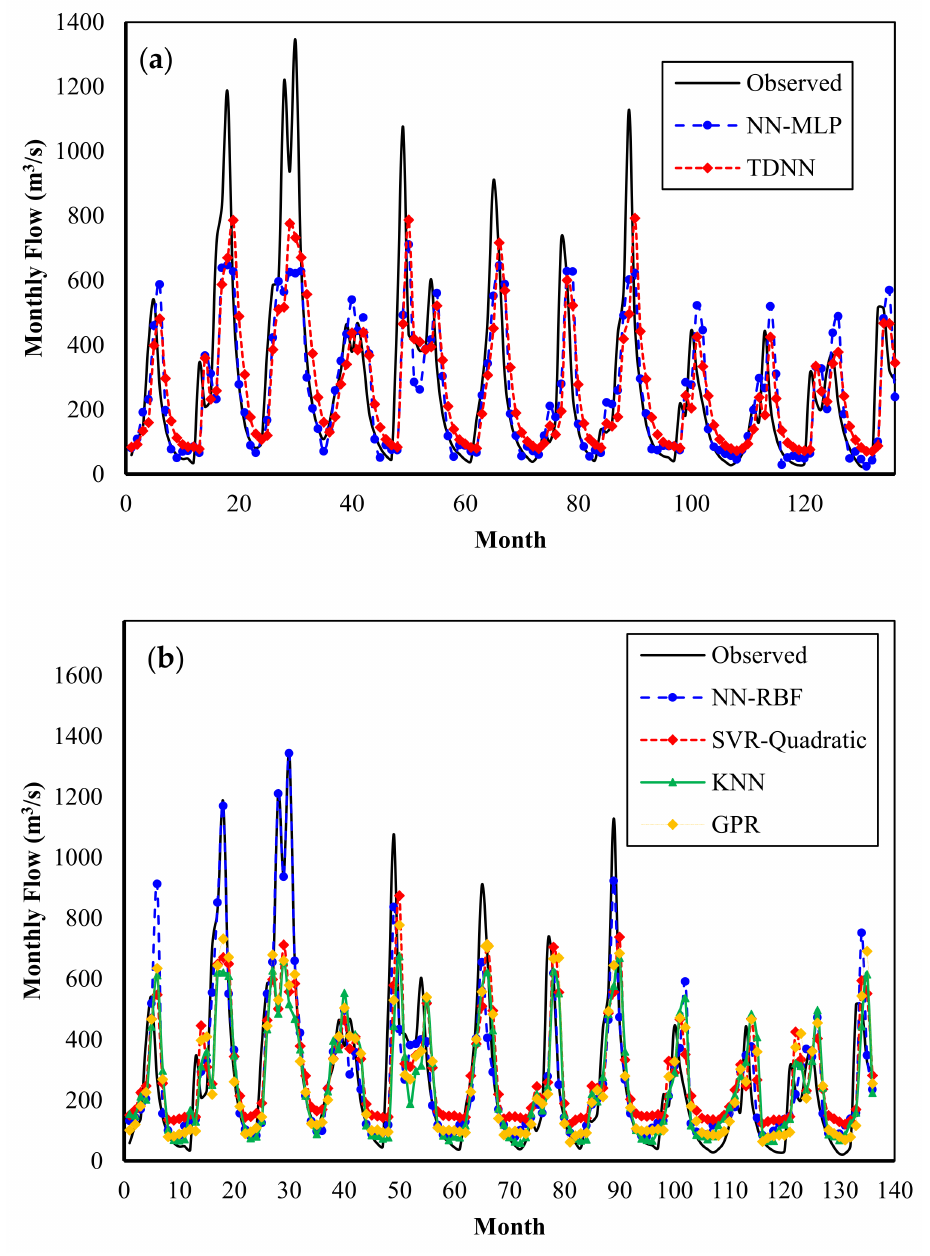
Figure 12. Monthly flow prediction for verification dataset for Dez Basin: ( a ) NN-MLP and TDNN, and ( b ) NNRBF, SVR-Quadratic, KNN and